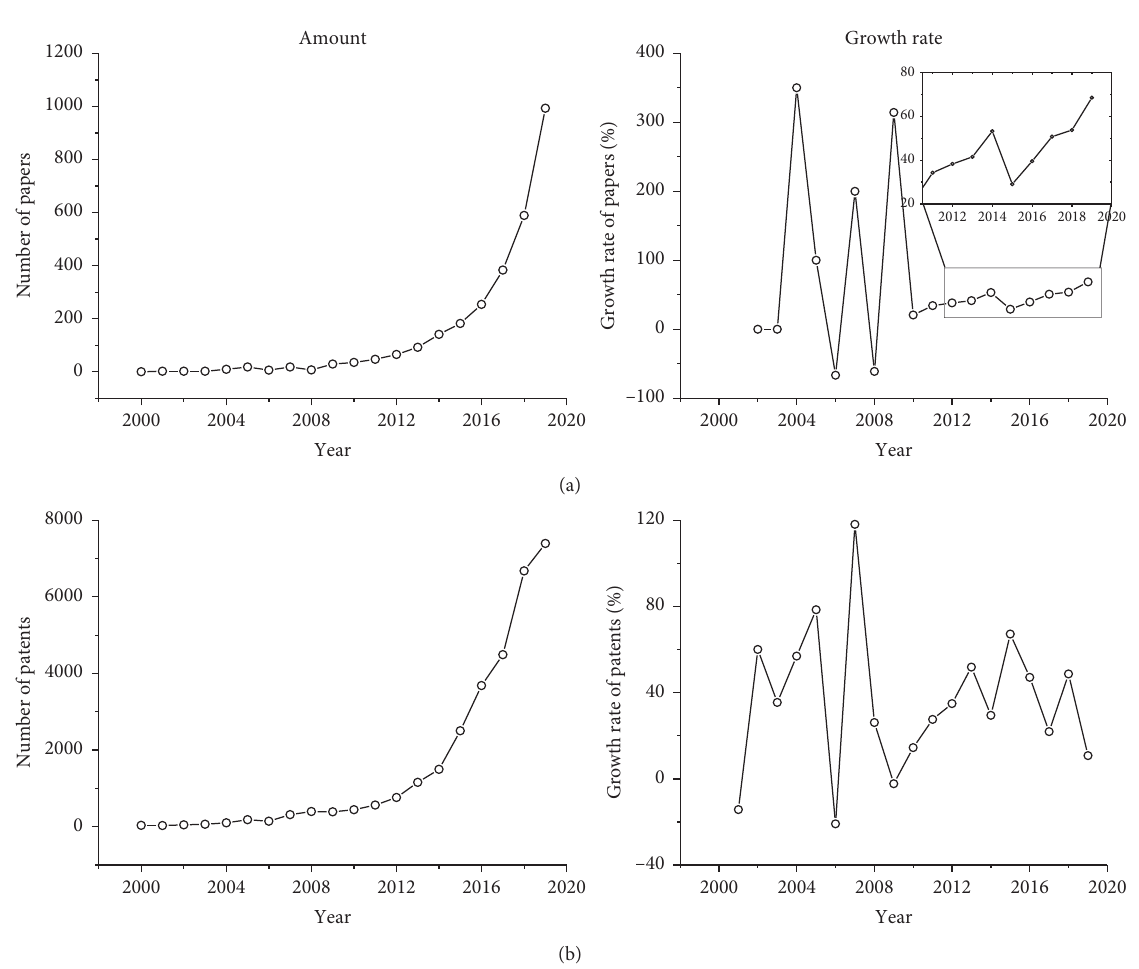
Figure 2: The annual amount and growth rate of the scientific (a) papers and (b) patents.